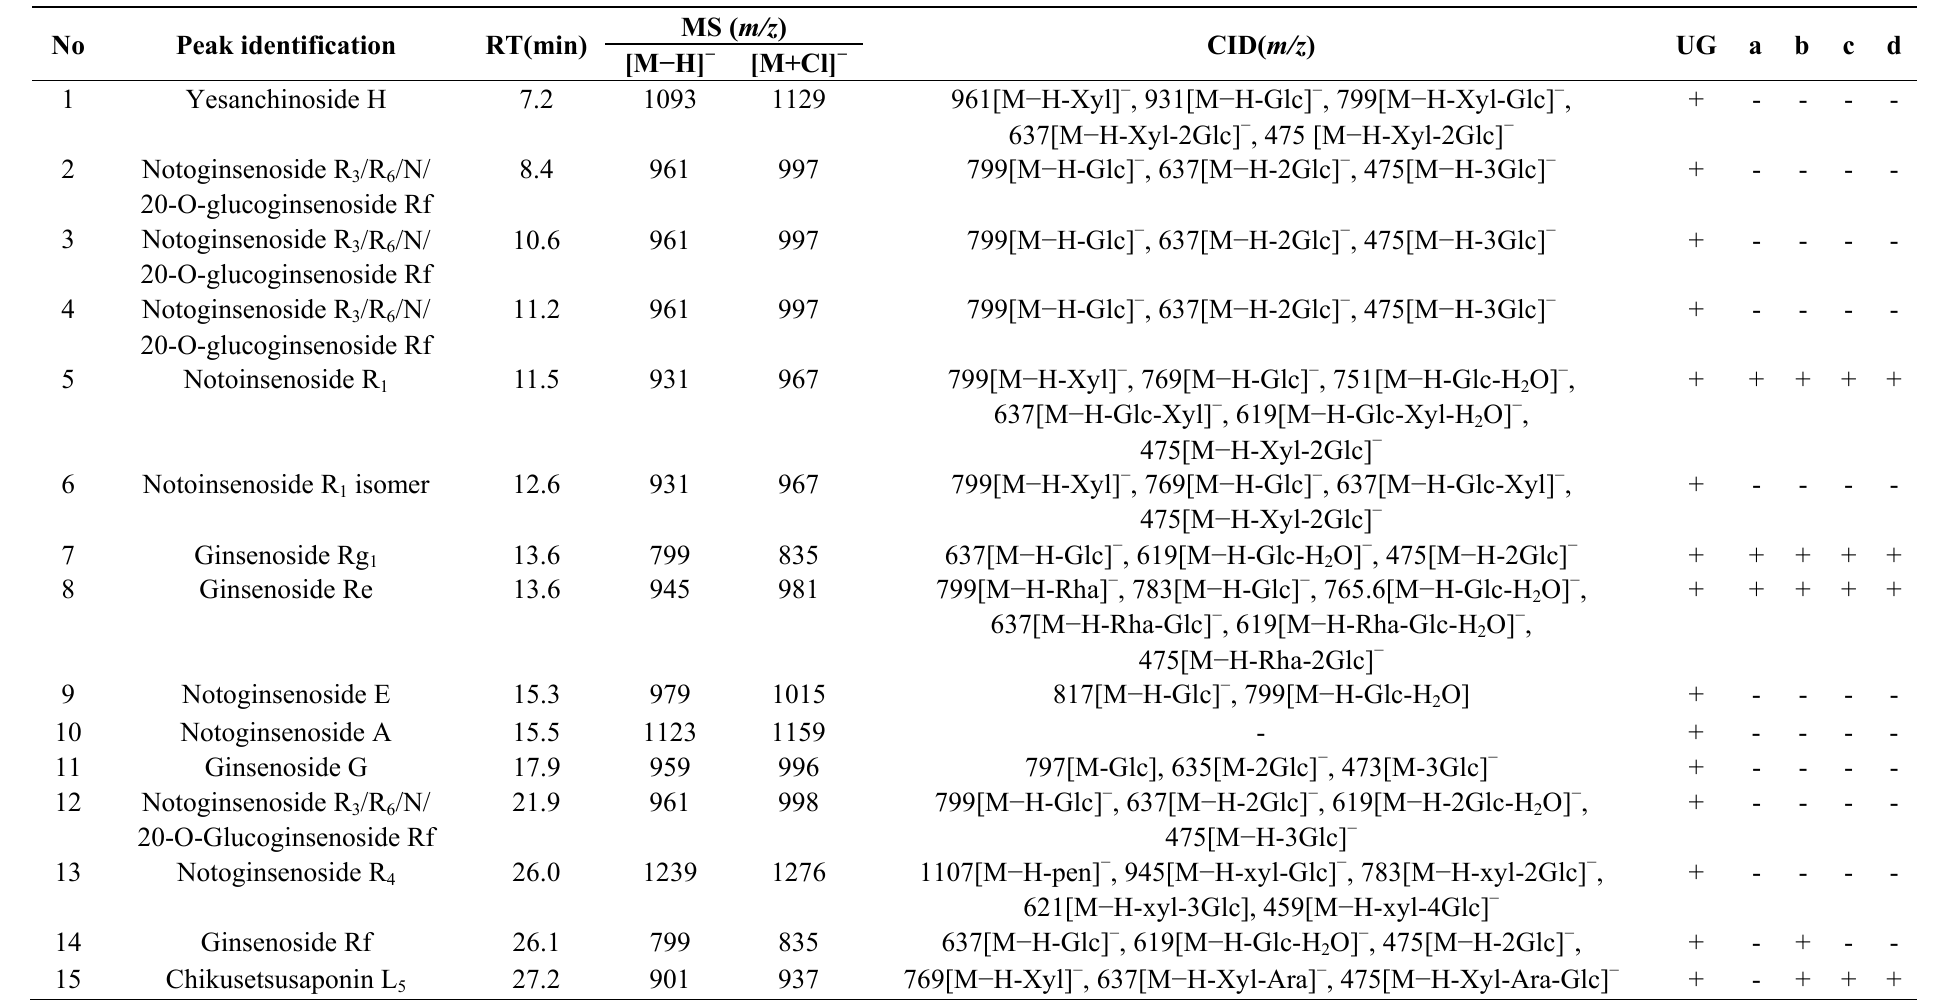
Table 1. HPLC-ESI-MS and corresponding CID data of saponins in different parts of P.